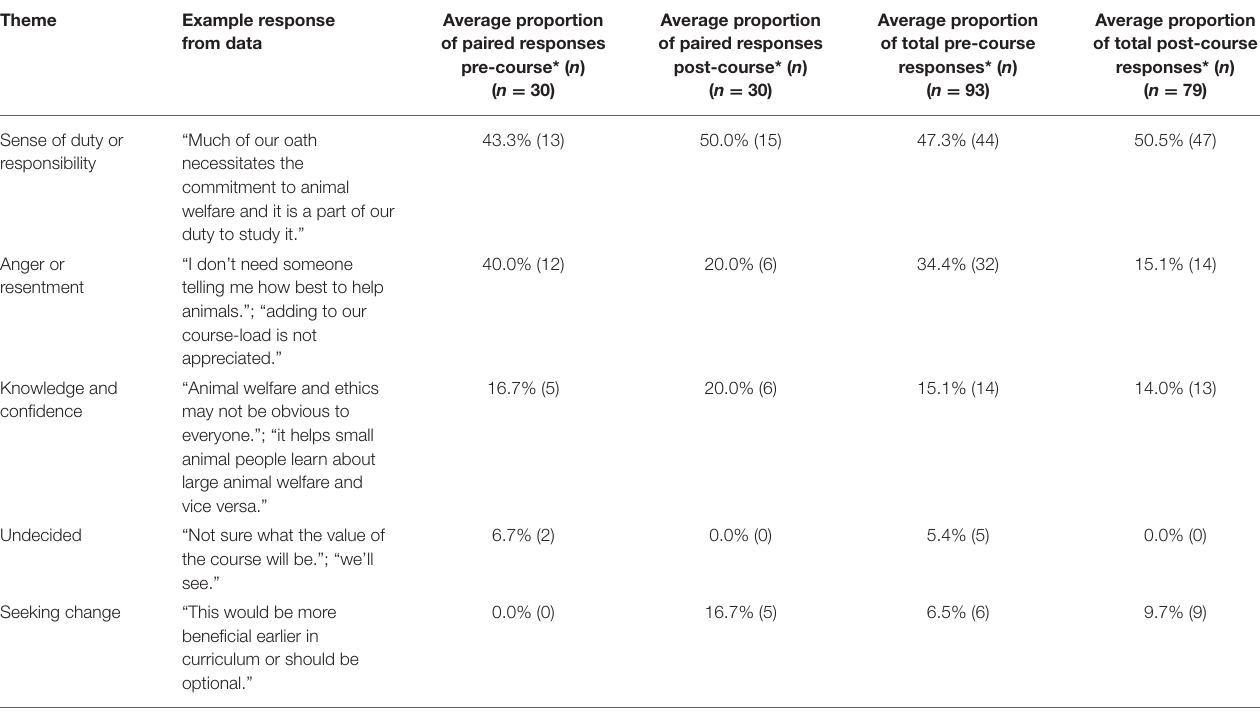
TABLE 6 | Qualitative thematic proportions of responses for write-in survey data.